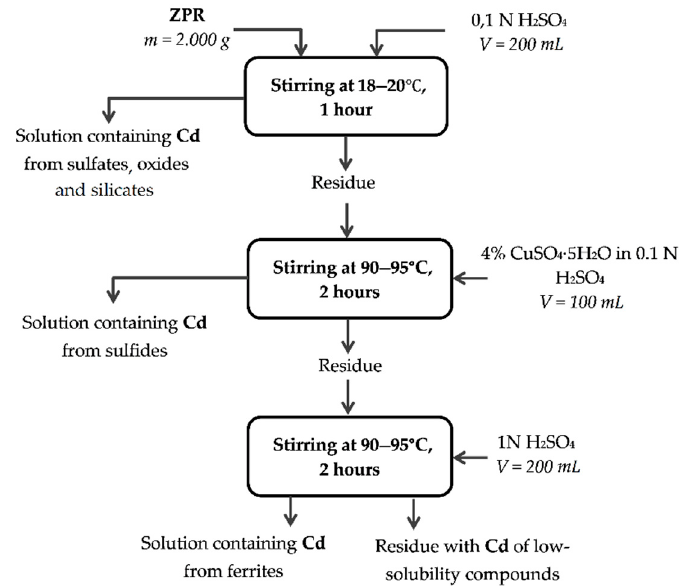
Figure A3. Method of chemical phase analysis of cadmium compounds.